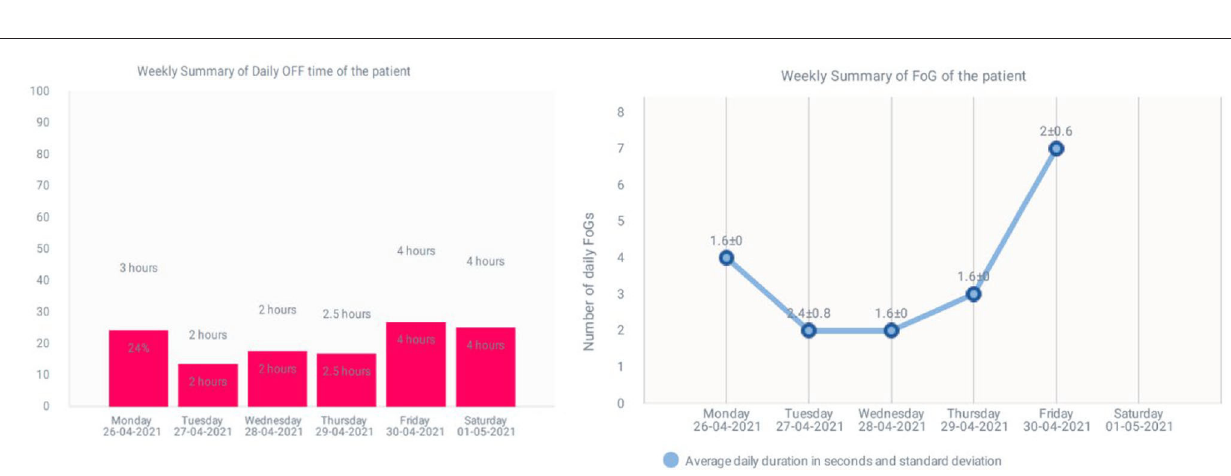
Frontiers in Neurology |